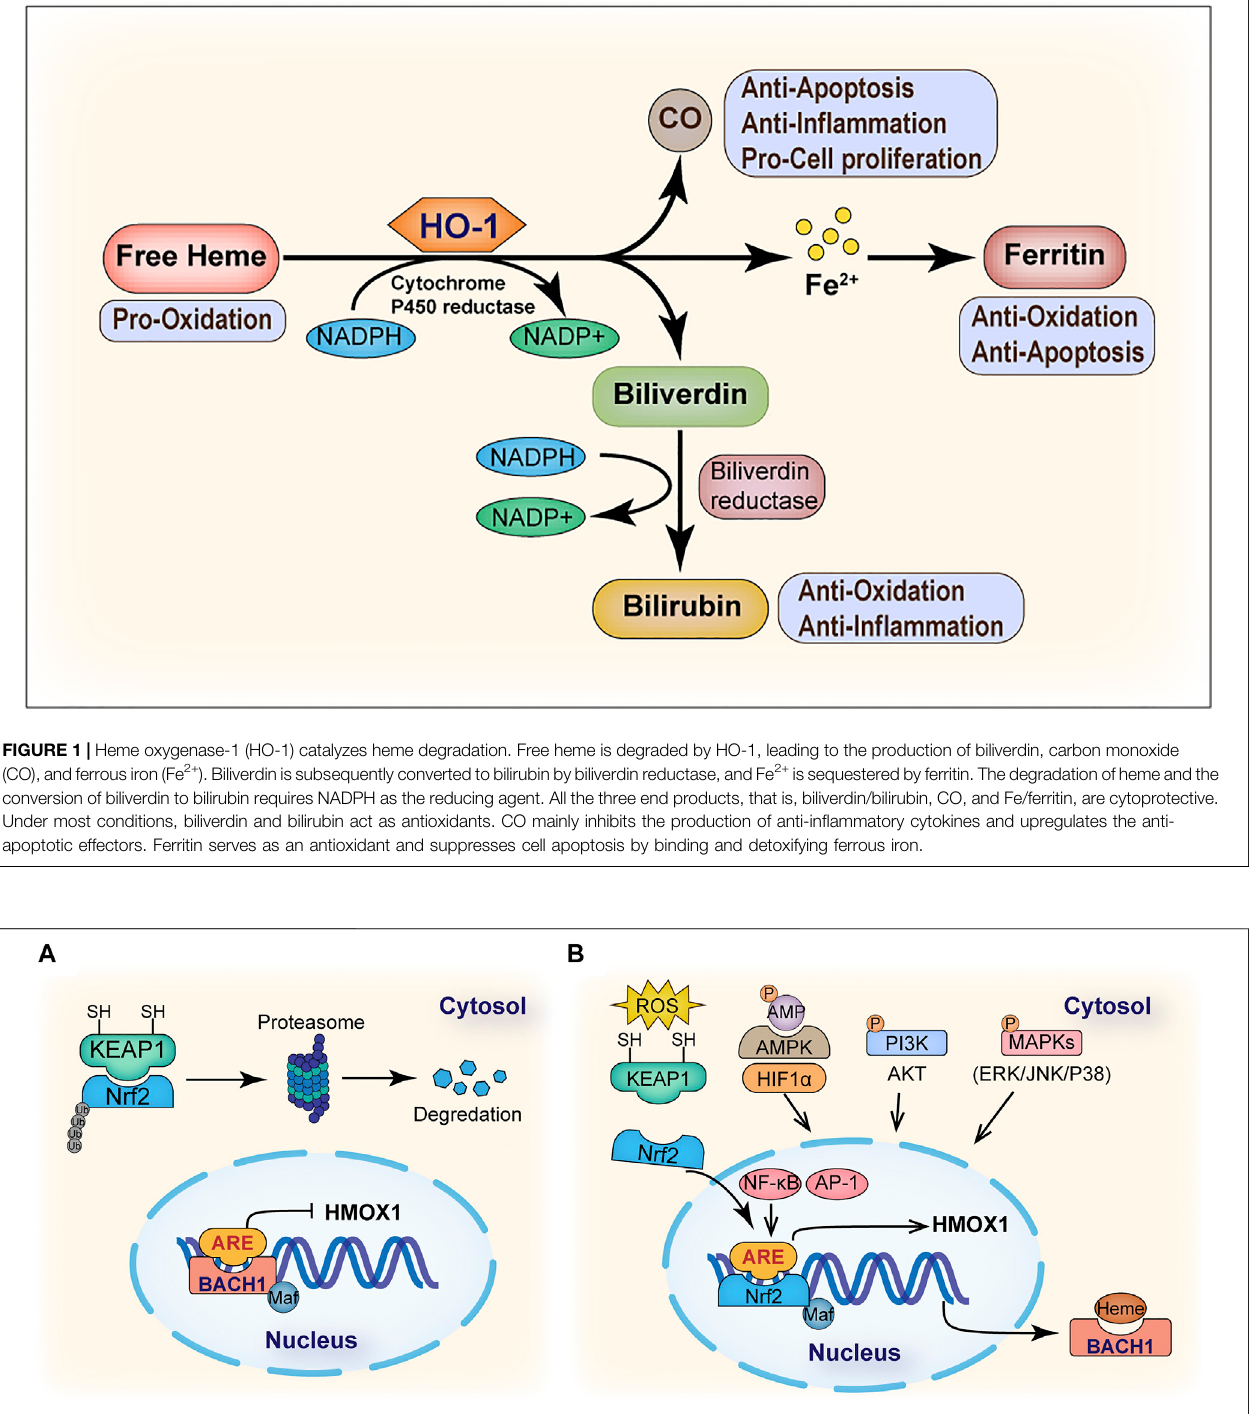
Frontiers in Cell and Developmental Biology |